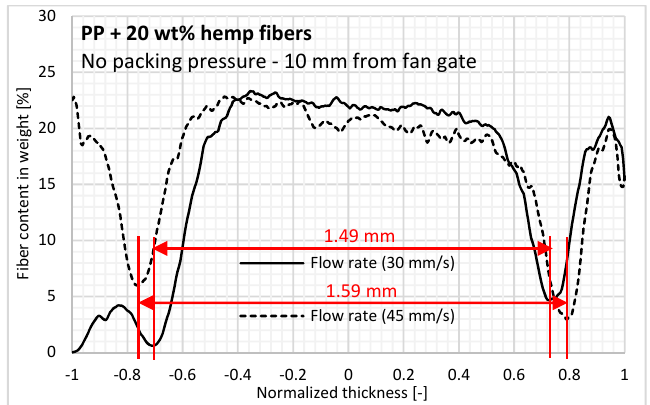
Figure 8. Effect of injection flow rate on in-thickness fiber content3.6.2. Effect of Packing Pressure.